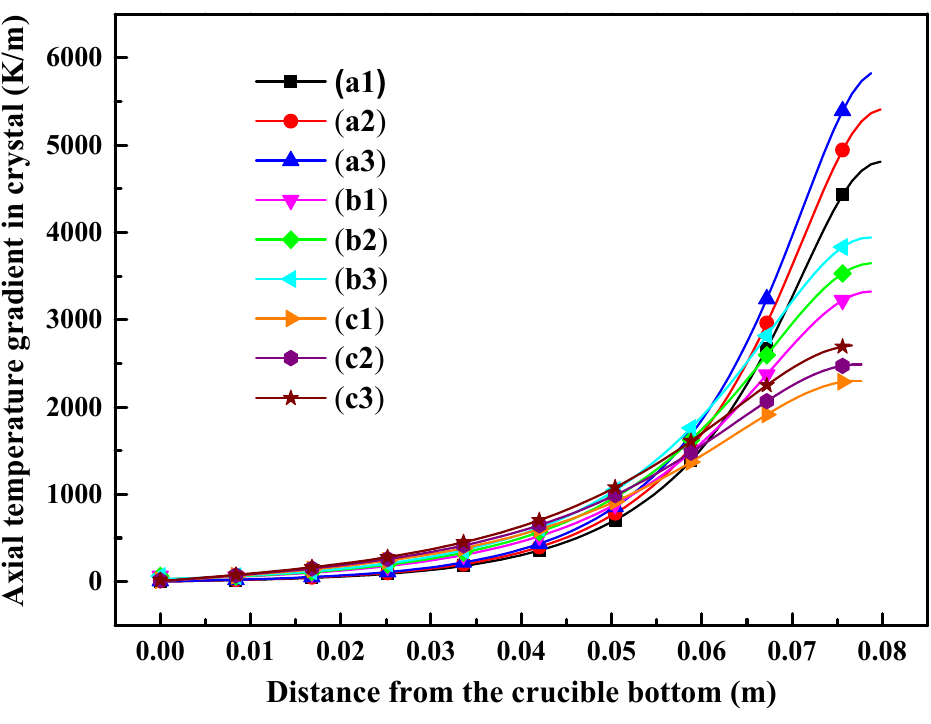
Figure 5. The axial temperature gradient in the crystal when the melting zone is 0.08–0.12 m from the bottom of the crucible. ( a1 ) crystal radius 0.01 m, the maximum furnace temperature 1030 K; ( a2 ) 0.01 m, 1040 K; ( a3 ) 0.01 m, 1050 K; ( b1 ) 0.015 m, 1030 K; ( b2 ) 0.015 m, 1040 K; ( b3 ) 0.015 m, 1050 K; ( c1 ) 0.02 m, 1030 K; ( c2 ) 0.02 m, 1040 K; ( c3 ) 0.02 m, 1050 K.